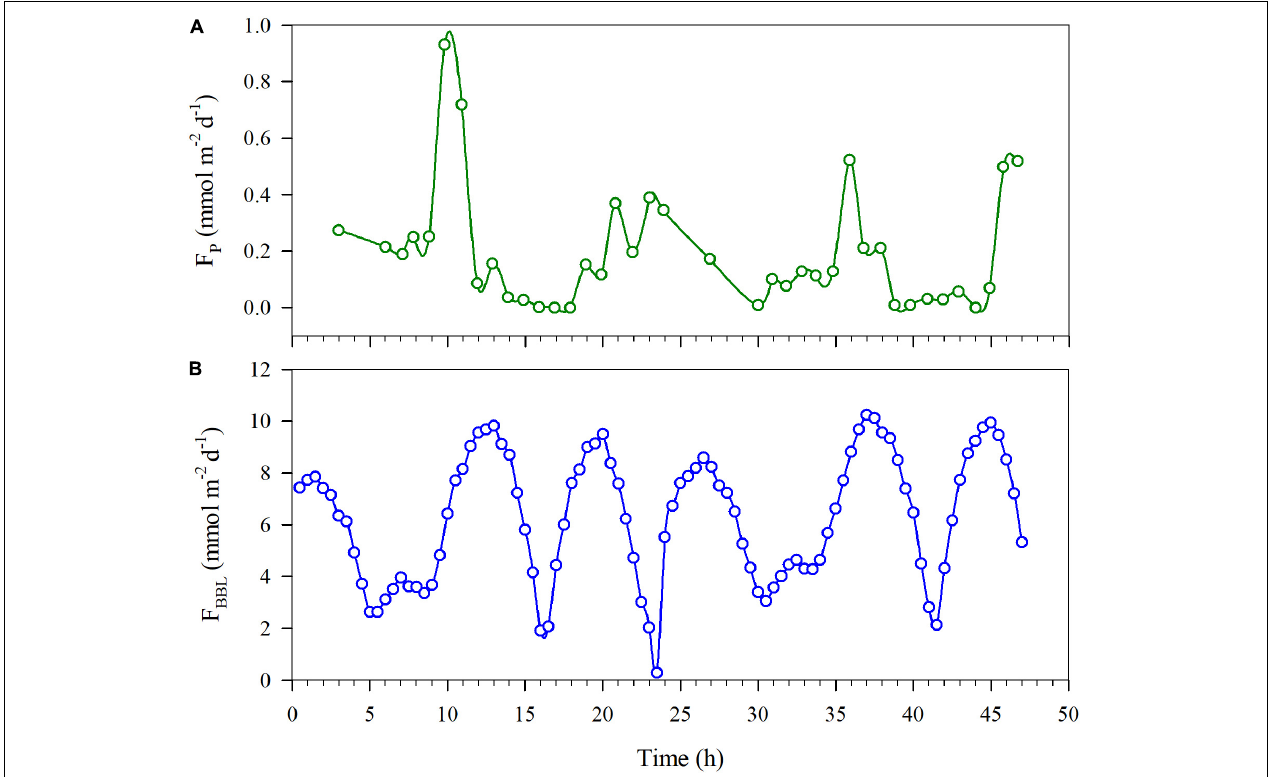
FIGURE 6 | Estimated DO fluxes at station A5 through the pycnocline (F p ) (A) and through the bottom boundary layer (F BBL ) (B) as a function of time.